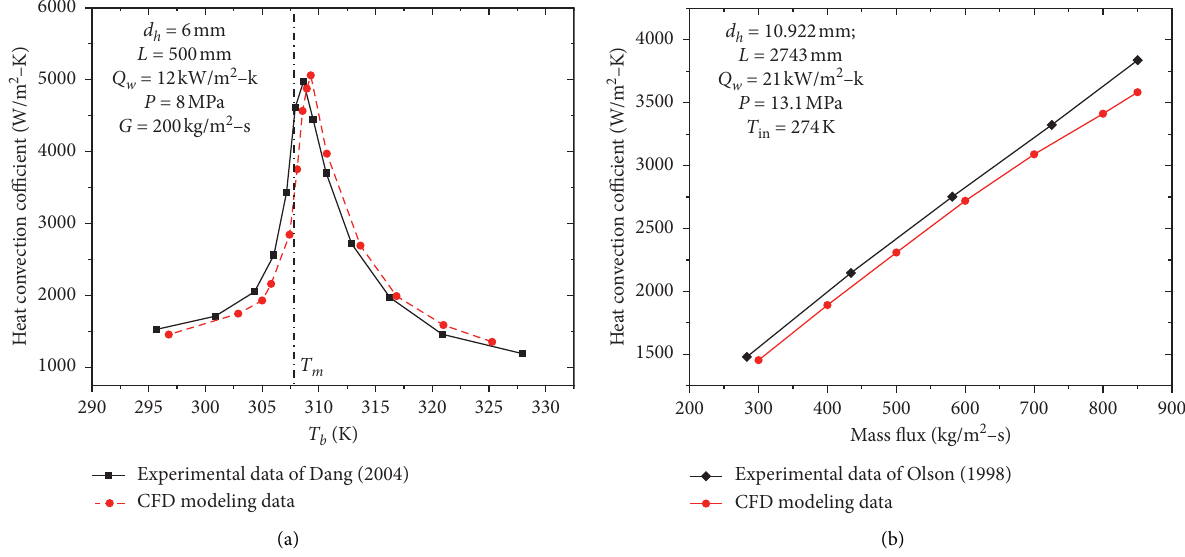
Figure 5: Verification with experimental data: (a) cooling condition; (b) heating condition.